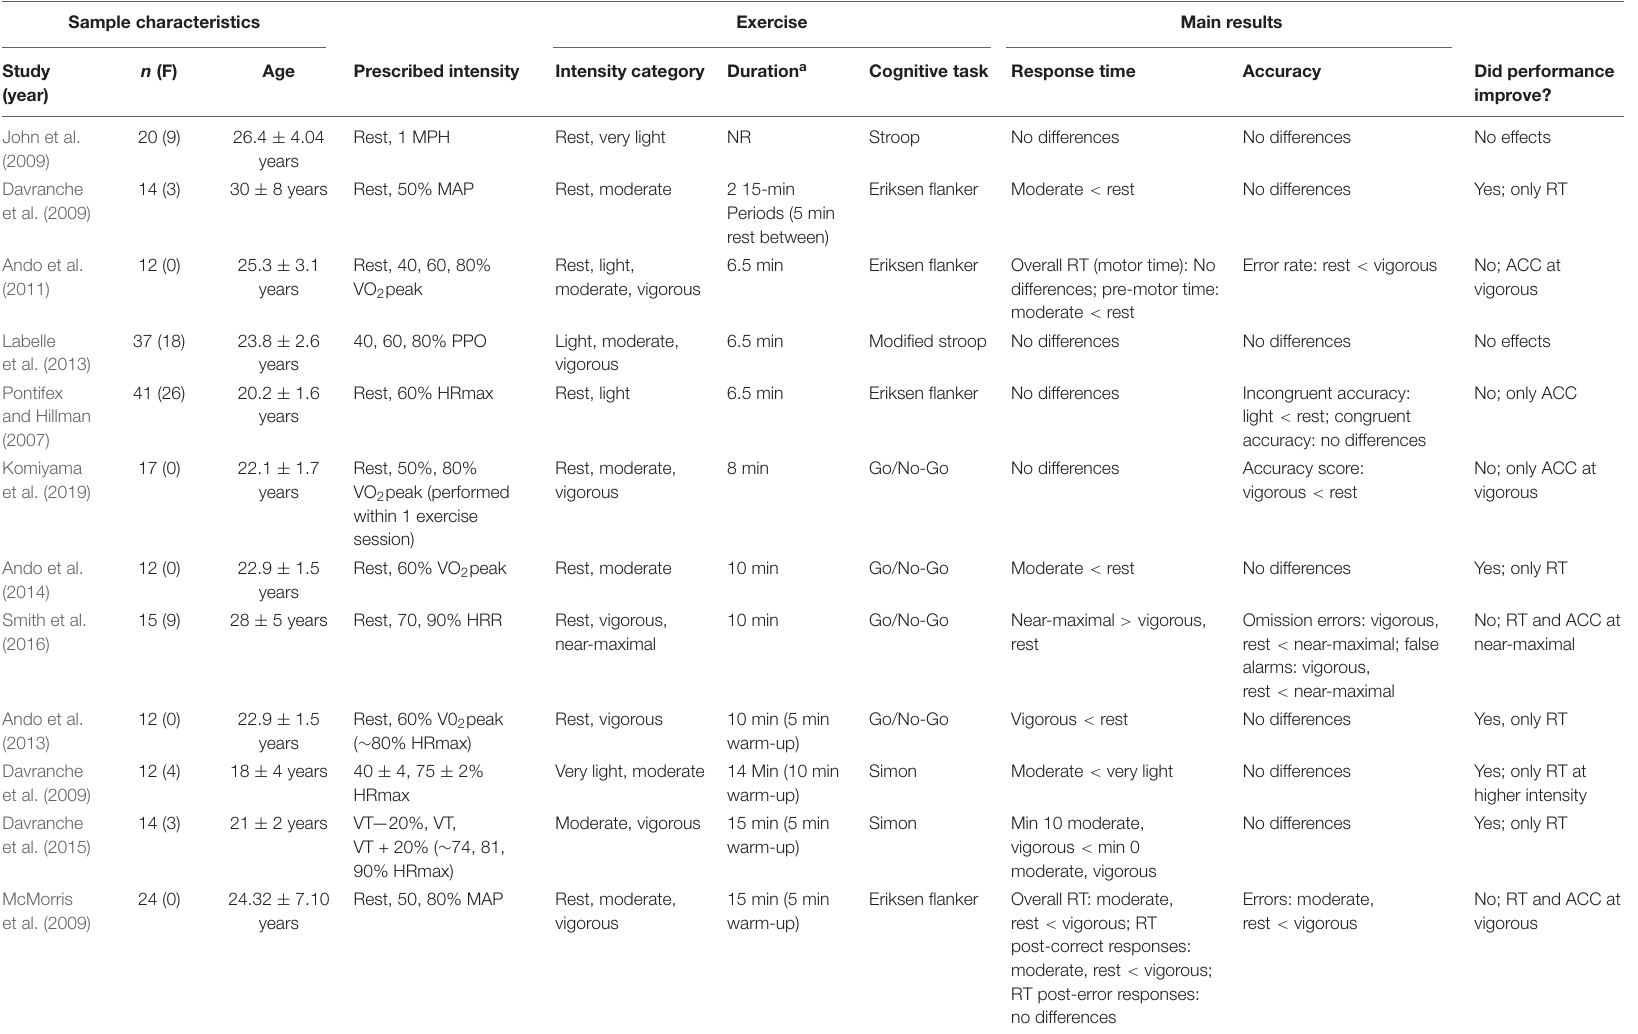
TABLE 1 | Summary of studies examining inhibition during acute aerobic